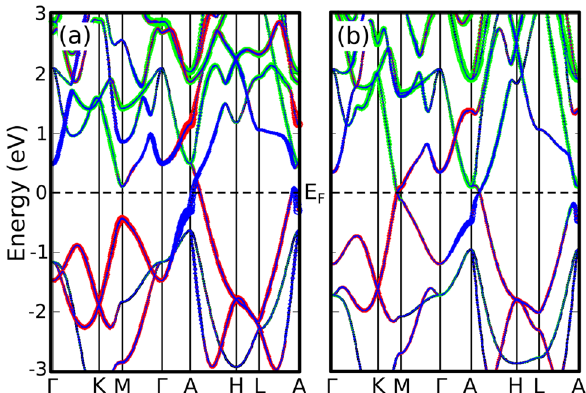
Figure 2. (Color online) DFT band structures for BaSn 2 . The orbital character is highlighted in colors: Sn s in blue, Sn p z in red and Ba d in green. The Fermi level is set at zero. ( a ) Band structure for P = 0 GPa (T1), there is one band crossing point in the A-H line. ( b ) Band structure for P = 6 GPa (T2), a second band crossing appears near the M